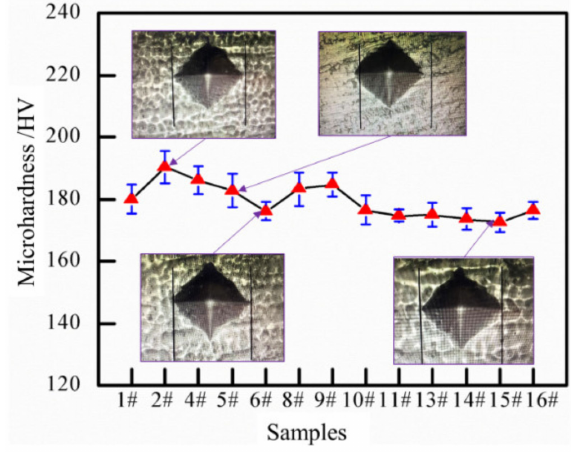
Figure 5. Microhardness of samples 1#–17#.